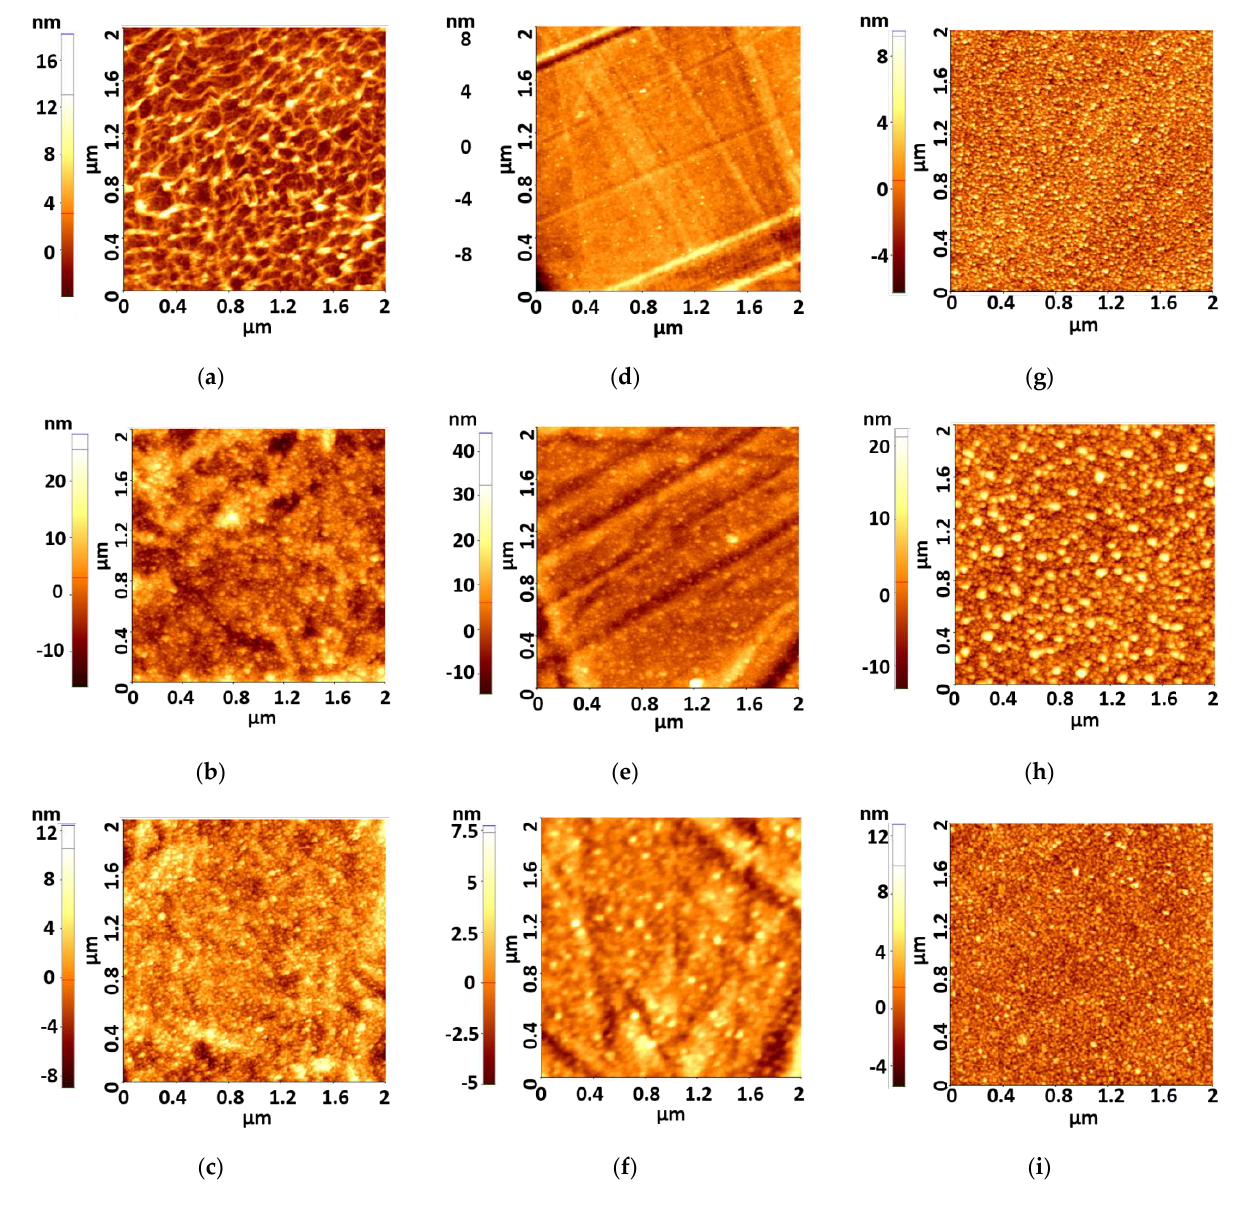
Figure 1. AFM images of as-deposited ultrathin films ( a ) PET-Ag1, ( b ) PET-Ag5, ( c ) PET-Ag9, ( d ) PETs--g1, ( e ) PETs-Ag5, ( f ) PETs-Ag9, ( g ) SO-Ag1, ( h ) SO-Ag5, ( i ) SO-Ag9. For the as-deposited films, the surface was crack-free, smooth, and homogeneous, composed of very small aggregates with a maximum height of ca. 9 nm. AFM 2D images of the Ag films show different morphologies of surface, depending on the Ag films’ thick- ness and substrates, which can be related to the agglomeration of crystallites and defects of PET surface. The most homogeneous films are those deposited on optical glass. The films deposited on thick PET show some wave-like deposition tendency, while films